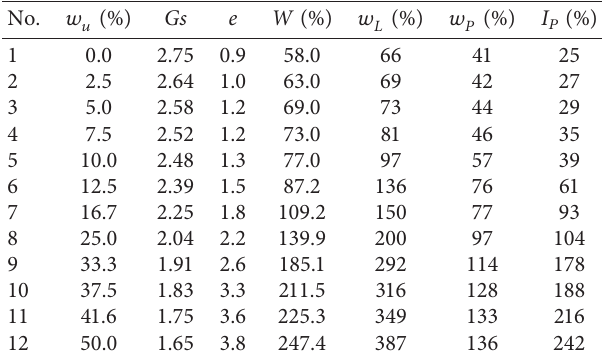
Table 3: Basic physical properties of